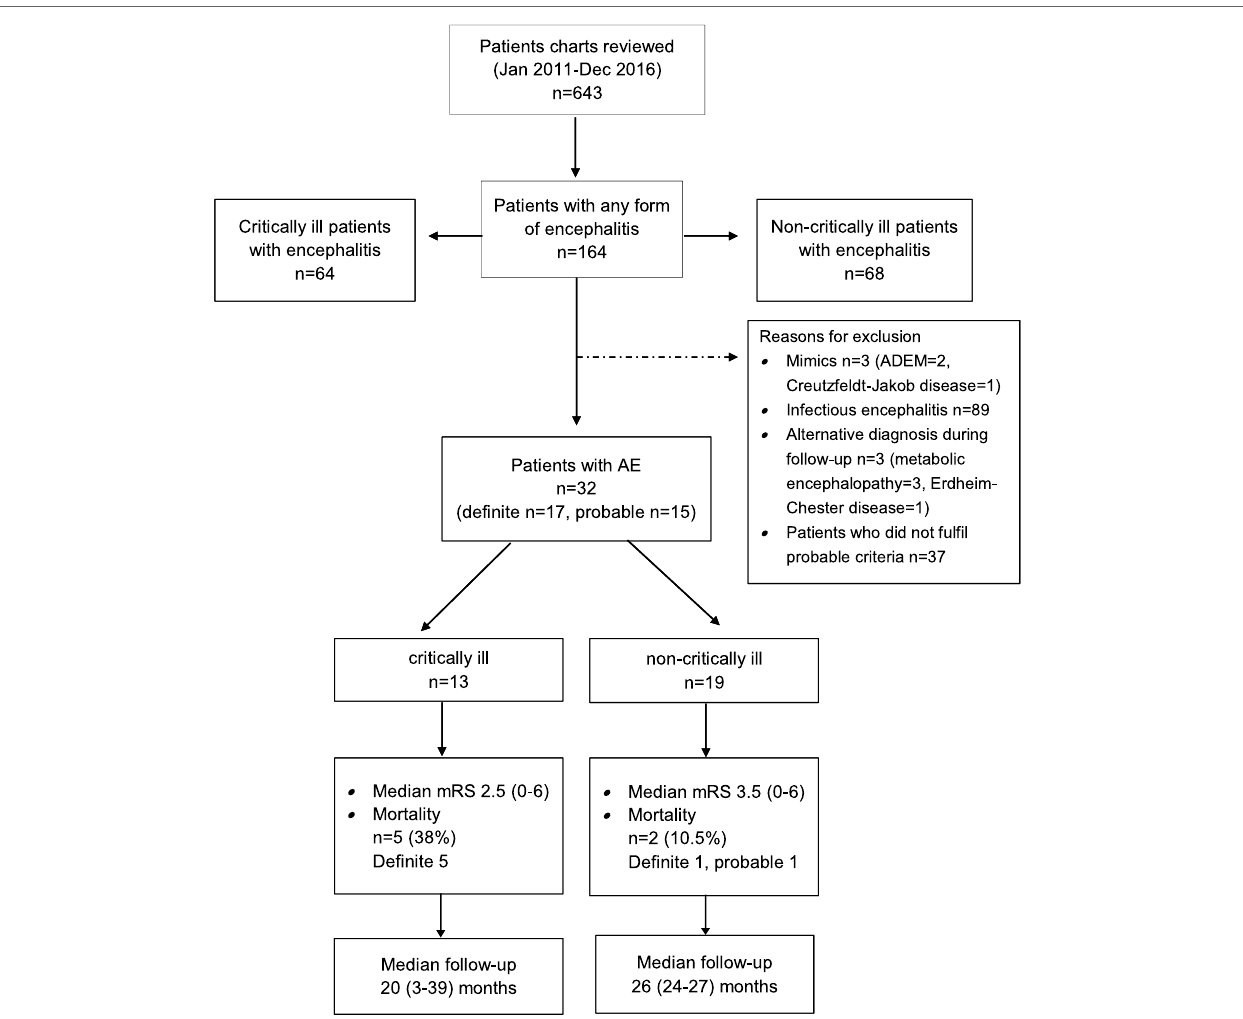
FigUre 1 | Patient selection and